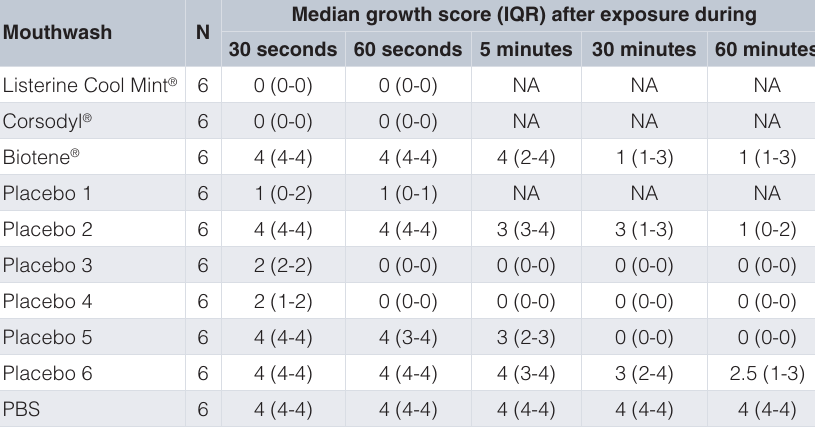
Table 3. Antimicrobial susceptibility of Neisseria gonorrhoeae isolates used in the experiment. Table 4. Growth of Neisseria gonorrhoeae after exposure to the mouthwashes.